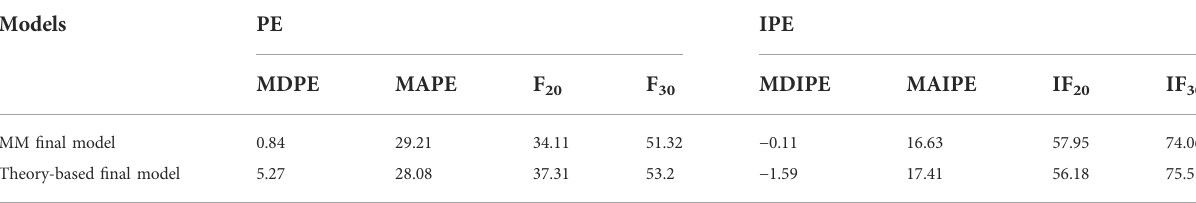
TABLE 5 The results of prediction error evaluation for the MM and theory-based fi nal models.